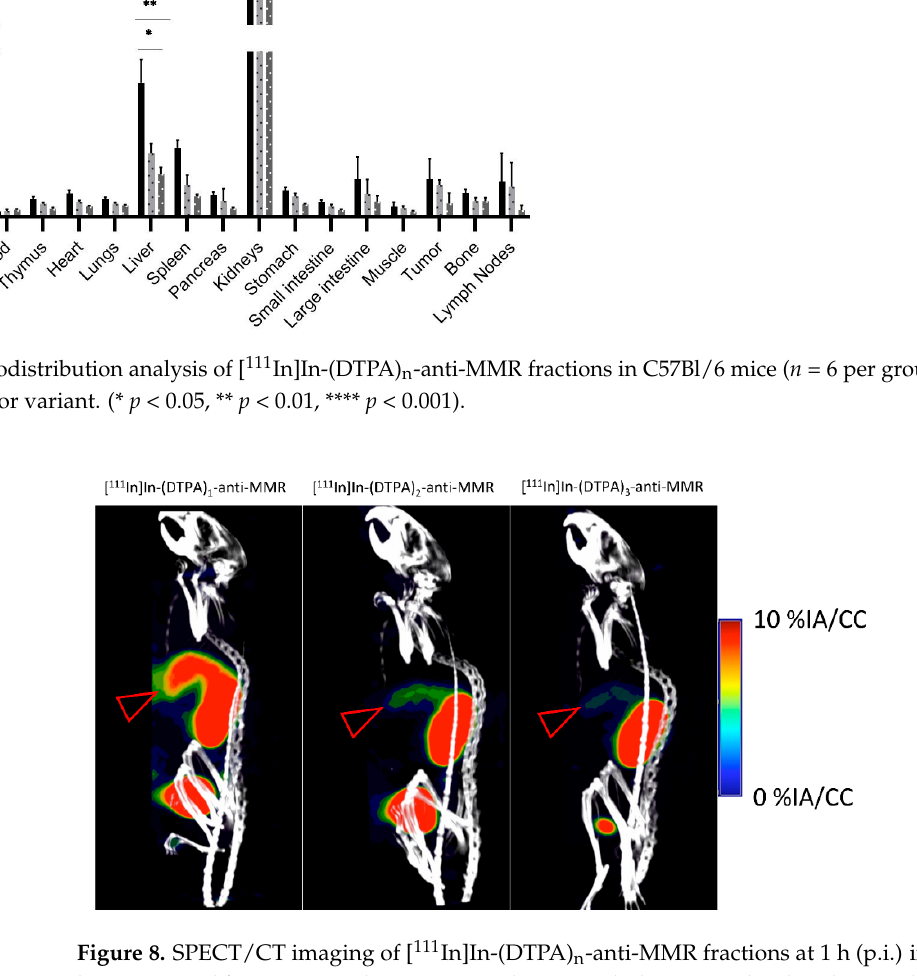
Figure 8. SPECT/CT imaging of [ 111 In]In-(DTPA) n -anti-MMR fractions at 1 h (p.i.) in 3LLR tumor bearing C57Bl/6 mice provides congruent data as with the ex vivo biodistribution data, where the liver (denoted by red arrow) clearly shows lower signal in fraction 2 and 3 compared to fraction 1. Tumors were not visible at this scaling.